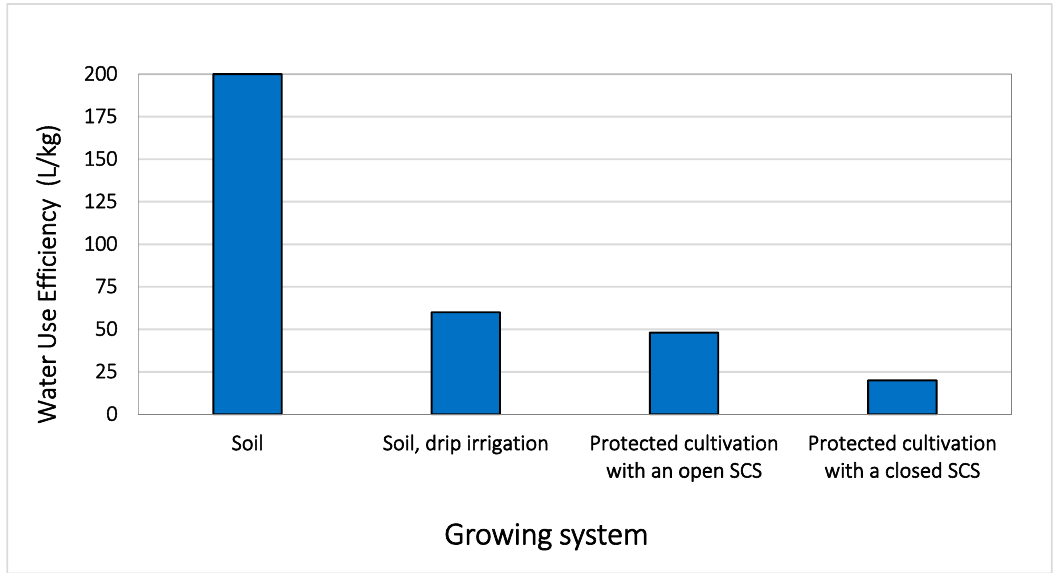
Figure 3. Applying new techniques and new irrigation systems can significantly improve water use efficiency, here calculated as L/kg tomatoes, using different growing systems. Soilless culture system (SCS) .